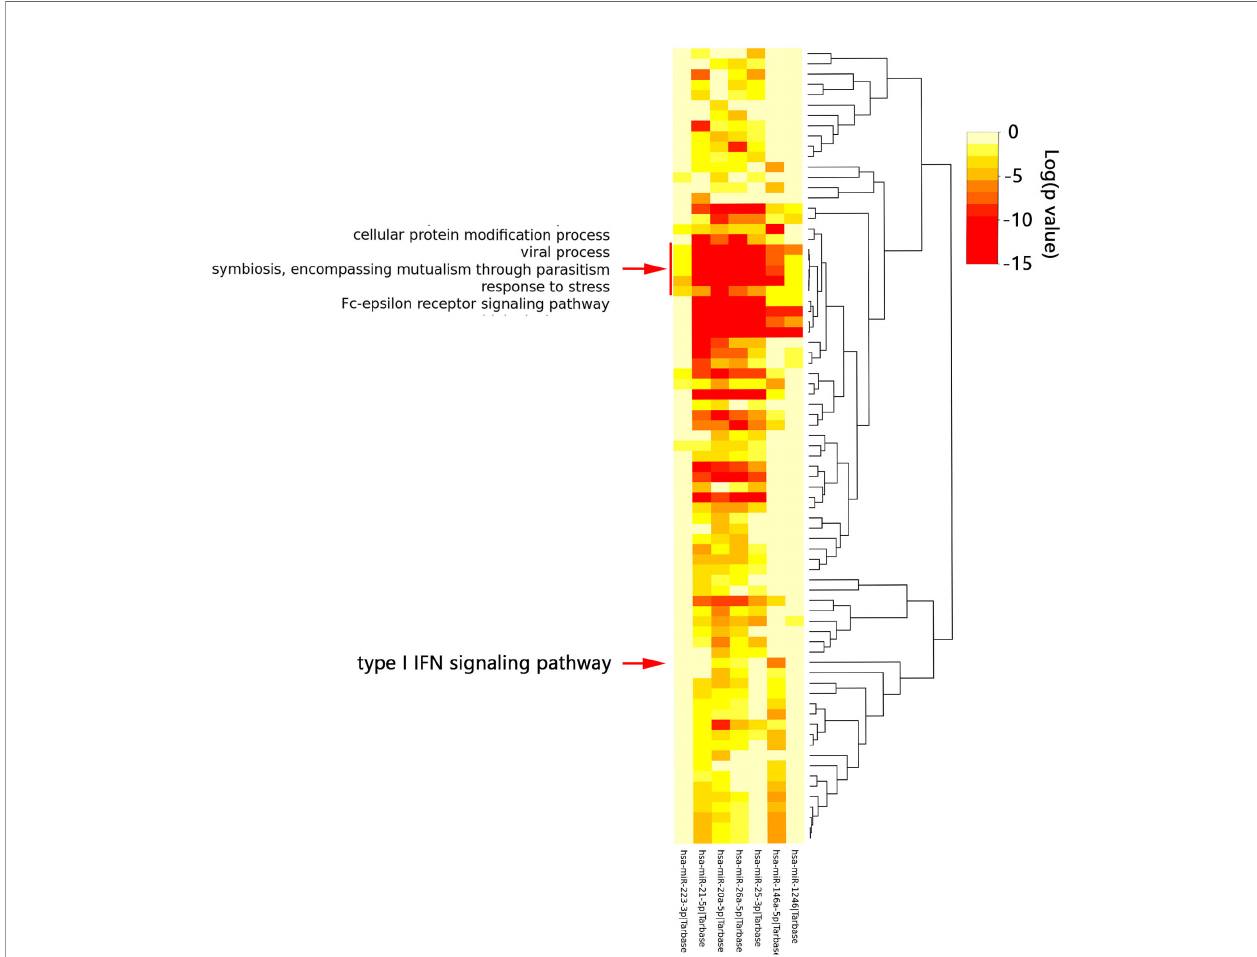
FIGURE 7 | The functional enrichment analysis of seven common miRNAs. The red arrow indicated the type I interferon signaling pathway. The red box indicated the biological processes regulated by all seven